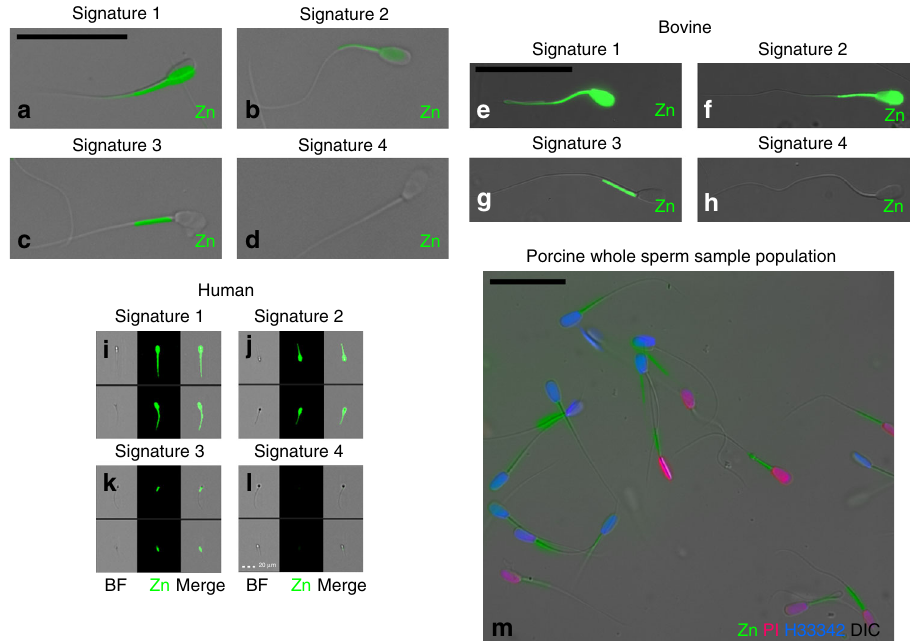
Fig. 1 Mammalian sperm zinc signature. a – d Epi fl uorescence microscopy of boar sperm zinc signature (green). e – h Epi fl uorescence microscopy of bull sperm zinc signature. i – l FlowSight image gallery of human sperm zinc signature (scale bar: 20 μ m). m Boar spermatozoa after 72 h of storage in Beltsville thaw solution (BTS semen extender) show varied zinc signatures. Imprecise fl uorescent to bright- fi eld overlay illustrates motile status (all scale